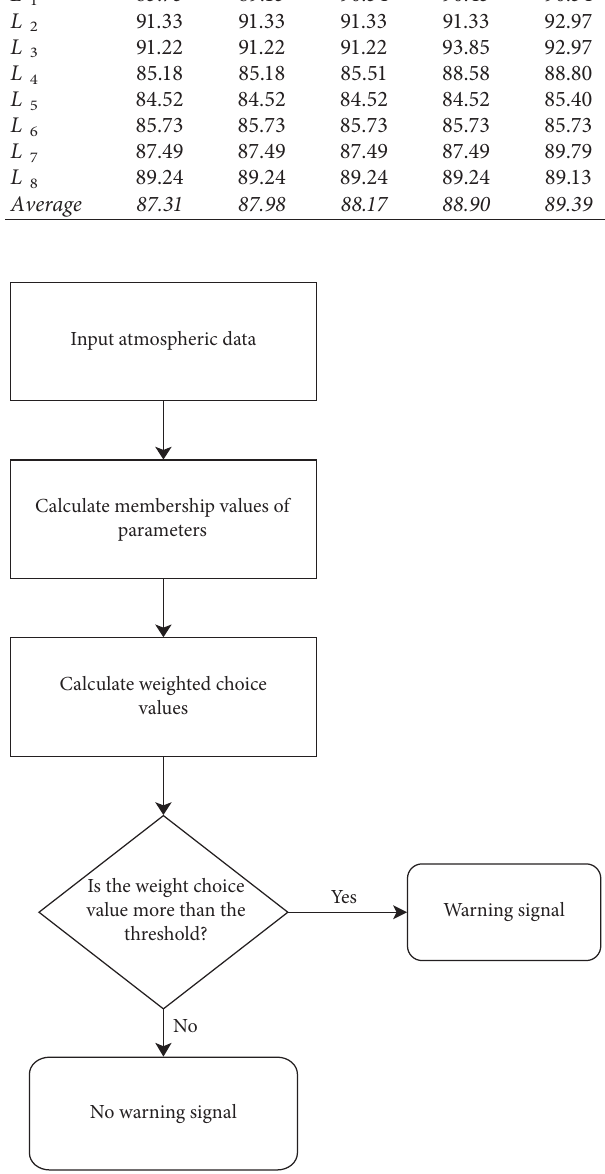
Figure 4: Flowchart of Algorithm 3.